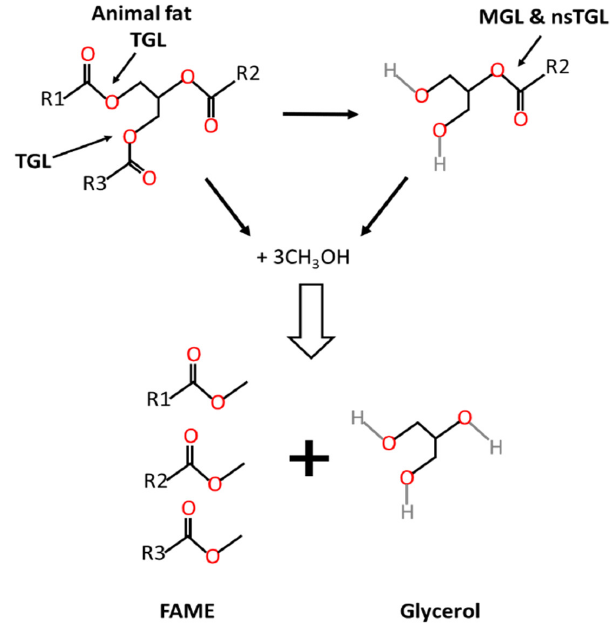
Figure 1. Transesterification of animal fat to biodiesel. TGL: triacylglycerol lipase; nsTGL: non specific triacylglycerol lipase; MGL: monoacylglycerol lipase.